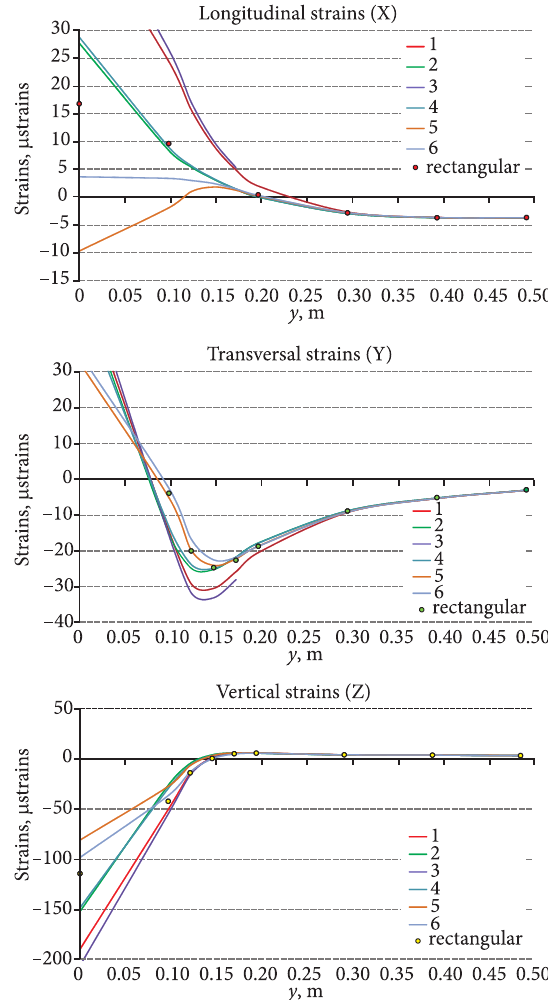
Fig. 3. Plots of strains versus y for different circular footprint super-positions and for a rectangular